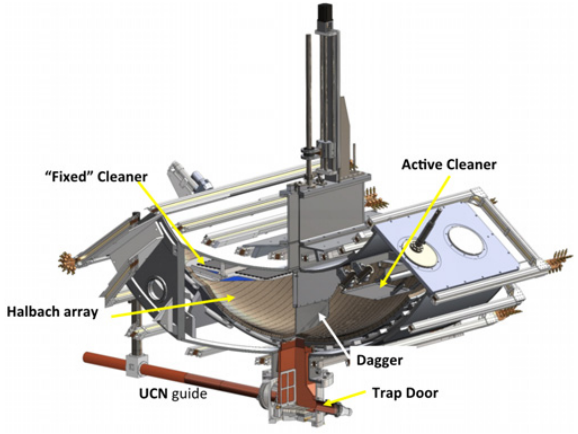
Figure 2. Dagger UCN rate using the coincidence method is shown for a typical long holding time nine-step unloading run from the 2017 data. The blue hashed area between t ∈ (0 , 150) s represents the filling period. The rates shown in green are during the cleaning phase and the black histogram shows the background rate during holding. Bins colored red are during the unloading or counting